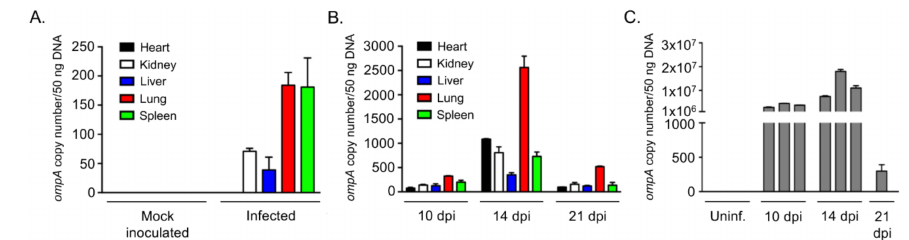
Figure 9. The ompA -57F/260R primer set amplifies ompA in qPCR from DNA recovered from the organs or blood of O. tsutsugamushi -infected mice. Fifty ng of DNA isolated on the indicated day post-infection (dpi) from the noted organs ( A , B ) or blood ( C ) from Swiss CD-1 mice that had been mock inoculated or that had been infected with O. tsutsugamushi Gilliam ( A ) or Karp ( B , C ). Each bar represents the mean + SD ompA copy number per 50 ng DNA recovered from an individual mouse analyzed in triplicate. Data are representative of at least three experiments with similar